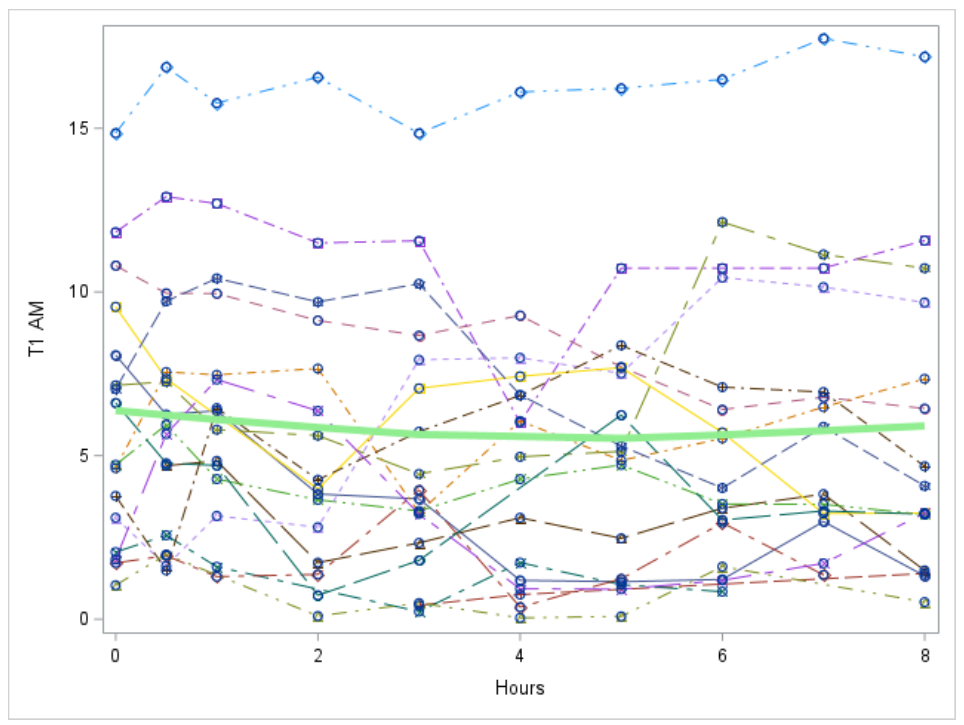
Figure A6. Study 2 by Week: 3,5-T2 trend over time (Each individual line represents a patient. The green line represents the mean values for all patients). T2 = 3,5-T2 concentration in nmol/L. There is no significant change in 3,5-T2 over time, p = 0.4982.